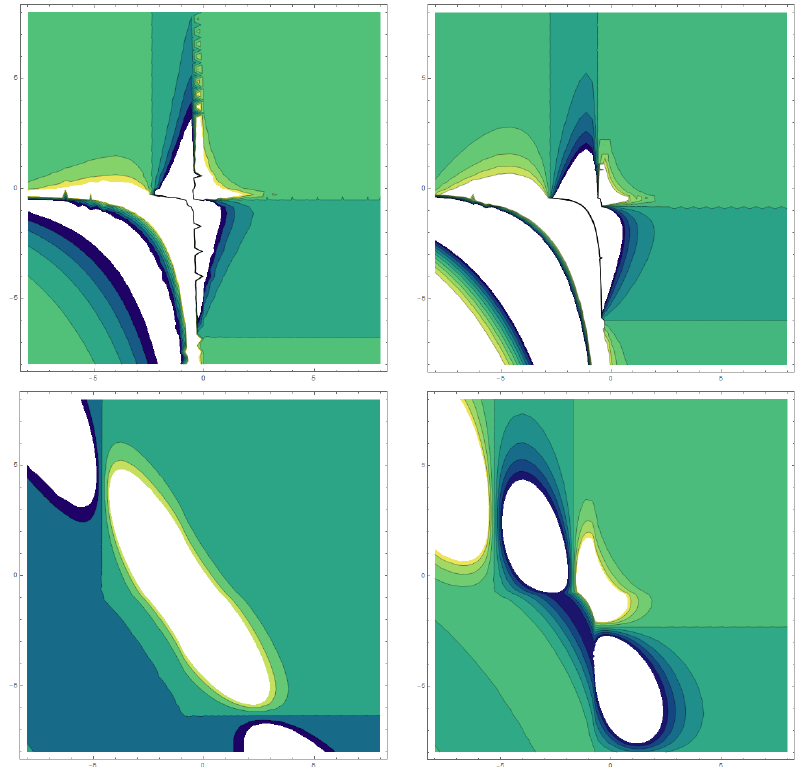
√ l = 2, c = 1, α = − 1, s 1 = 1 , µ 1 = 1, ζ 1 = 2, ν 1 = 3, where β = 0.3, 0.5, 0.7, 0.9 in the 2 figures below from the upper left to lower down the right side, respectively. Figure 10: This illustration portrays a realistic representation of | L 10 ( t , x ) | which is linked to the category of dark, singular solitary-wave solutions. Here is a graphic repre- sentation of a 3D plot over the interval ( − 0.5, 0.5 ) for different values of β , along with the √ parameters, such as ρ = e , l = 2, c = 1, α = − 1, s 1 = 1 , µ 1 = 1, ζ 1 = 2, ν 1 = 3, where 2 β = 0.3, 0.4, 0.7, 0.9 in the figures below from the upper left to lower down the right side, respectively.